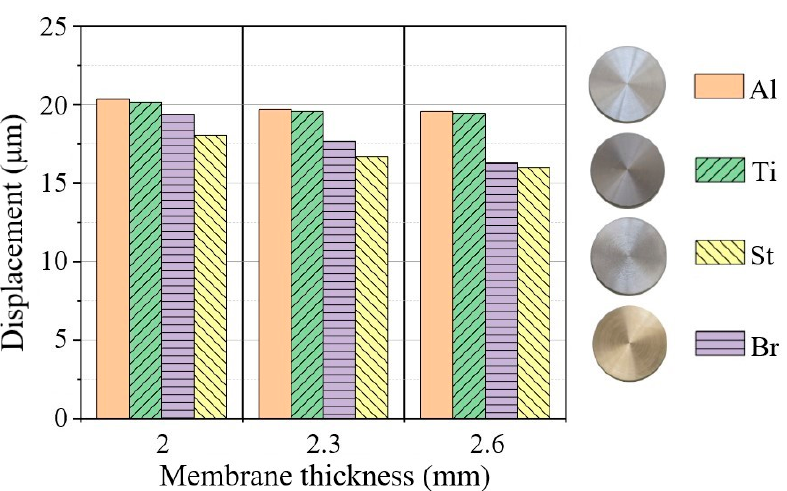
Figure 7. Vibration displacement amplitude vs. membrane thickness (aluminum, titanium, brass and steel membranes).